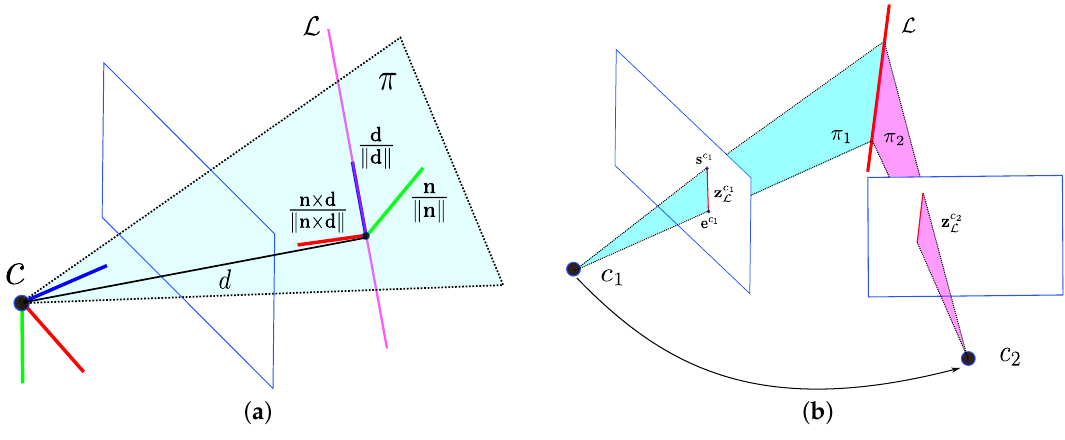
Figure 2. Plücker coordinates for line features. ( a ) Plücker line coordinates; ( b ) Initialization of a newly observed